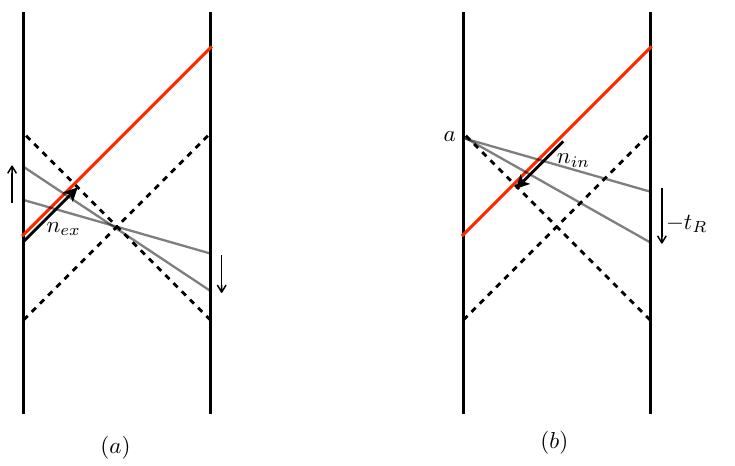
Figure 9 . Illustration of time slices used to define (a) exterior momentum, and (b) interior mo- mentum. The arrows show the direction of size